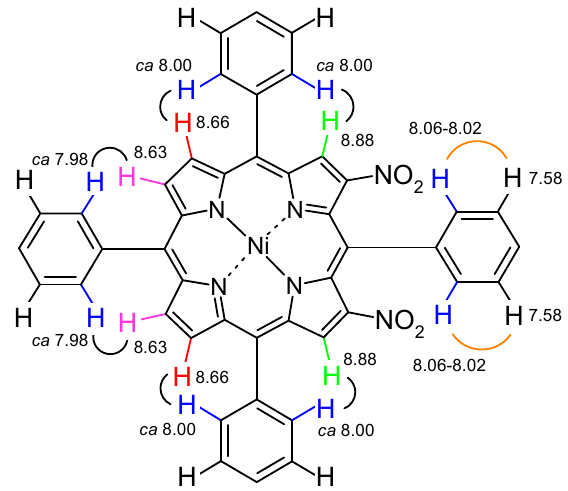
Figure 3. 1 H NMR spectrum of product 3db (diagnostic region: 7.50–9.00 ppm).